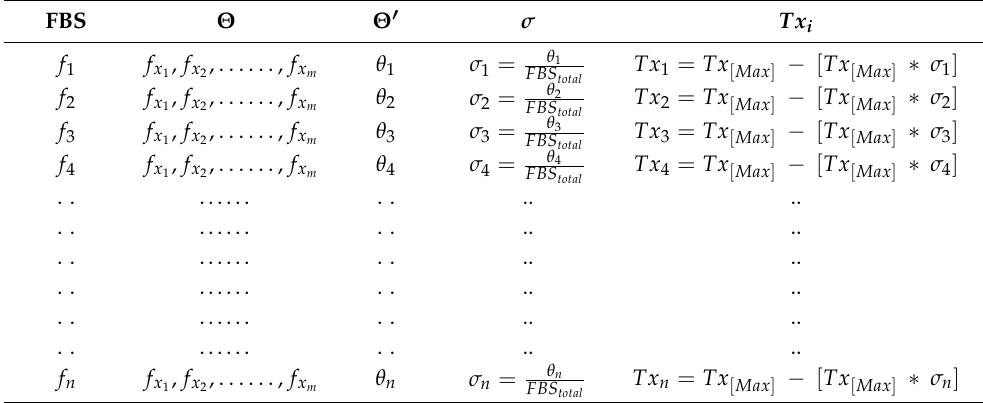
Table 6. Autonomous Tx power